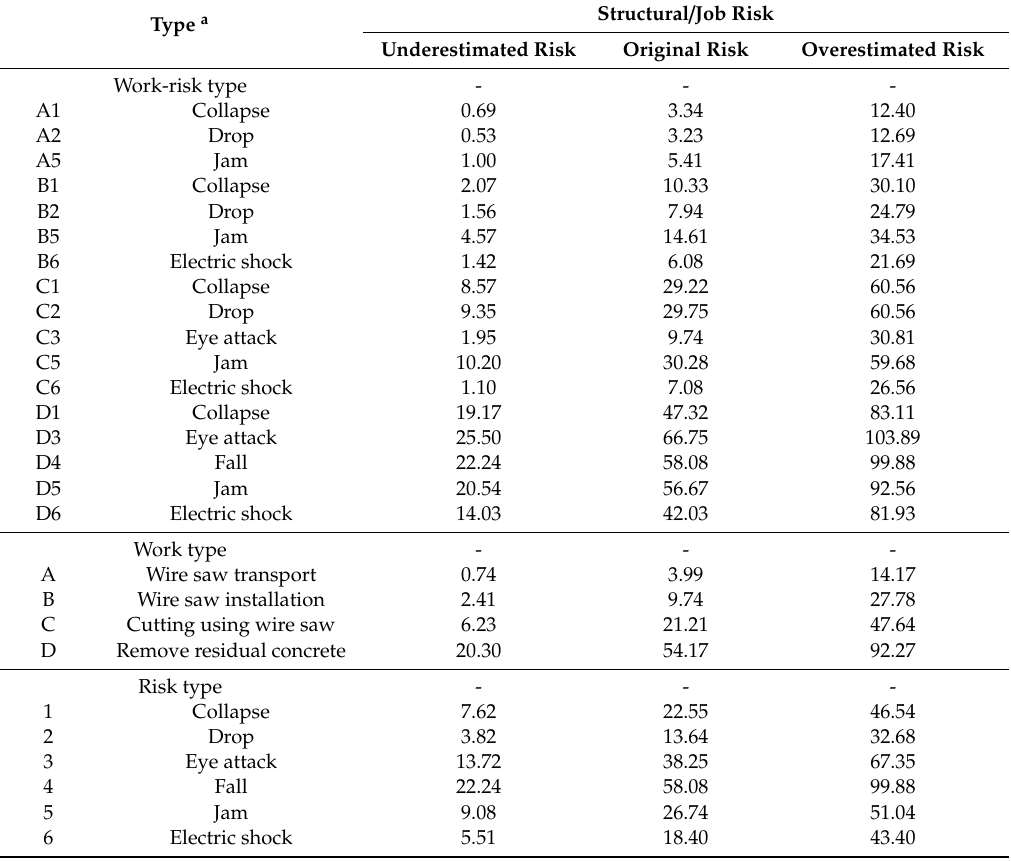
Figure 6. Sensitivity analysis on structural/job risks by risk type. Table 14. Results of sensitivity analysis on structural/job risks.